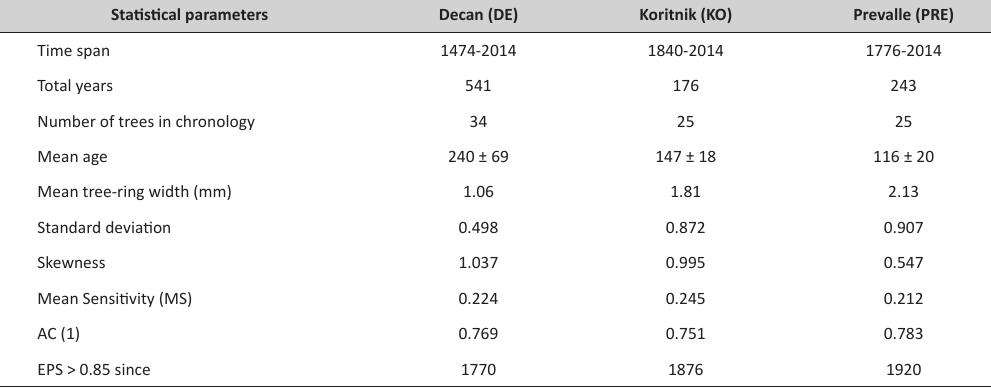
taBLe 2. Statistical parameters of three P. hedreichii chronologies from Kosovo statistical